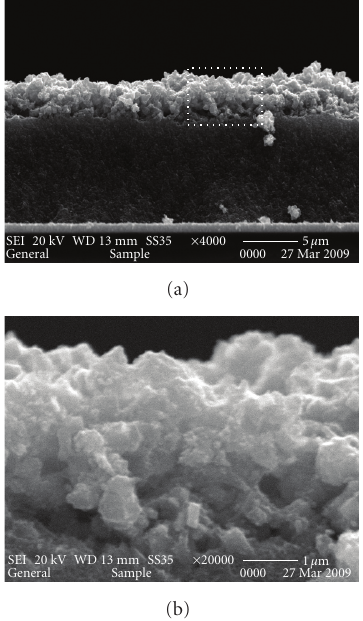
Figure 3: Cross-sectional views of a double-layer electrode pre- pared by mechanically breaking the substrate. The white dotted quadrangle in Figure 3(a) indicates the zoomed-in area shown in Figure